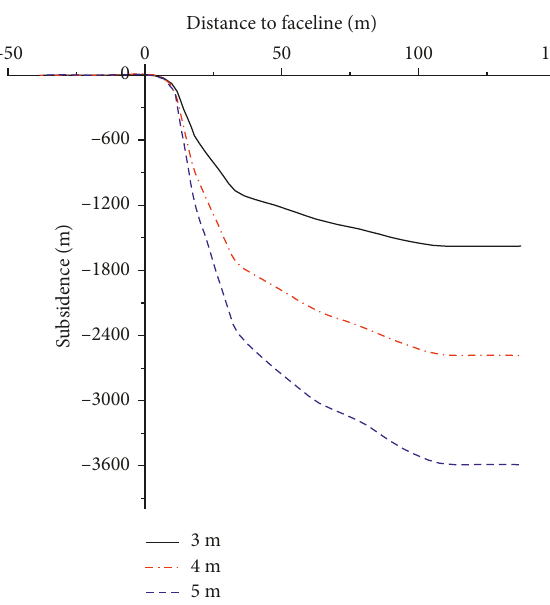
Figure 11: Influence of the mining height on the subsidence of the voussoir beam